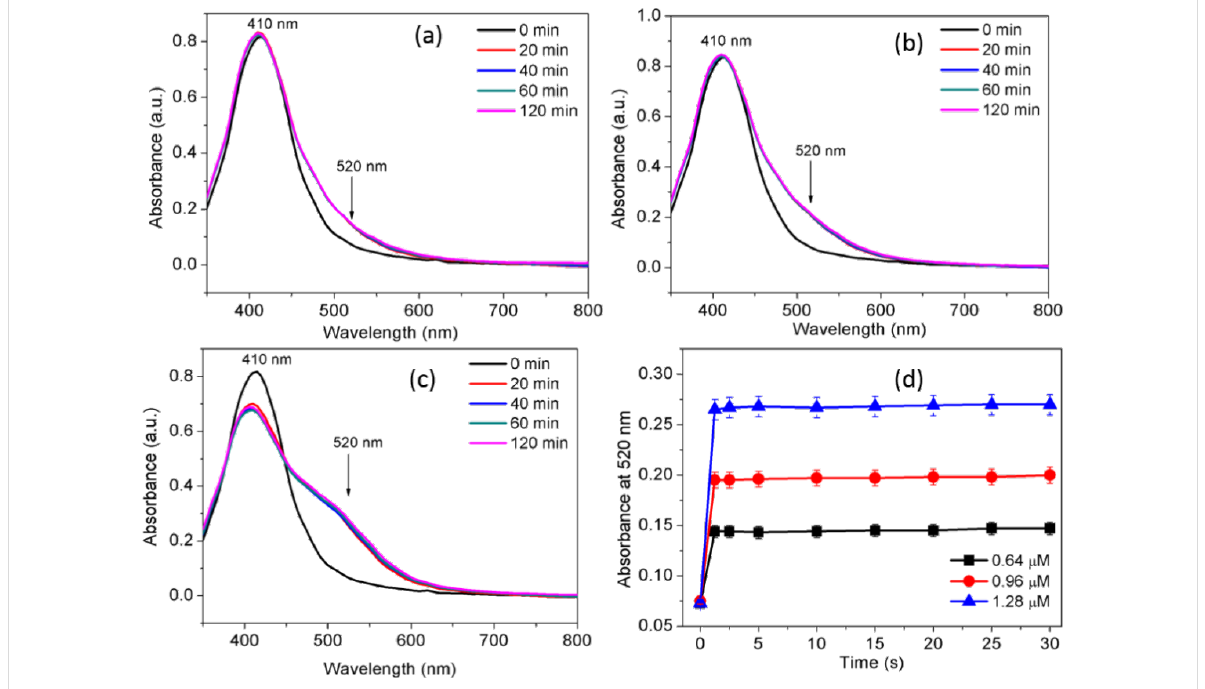
Figure 6: Time course of the spectral response of silver nanoparticles in the presence of (a) 0.64, (b) 0.96, and (c) 1.28 µM Cu 2+ . (d) Time course of the absorbance intensity of silver nanoparticles recorded in the presence of the three different Cu 2+ concentrations.